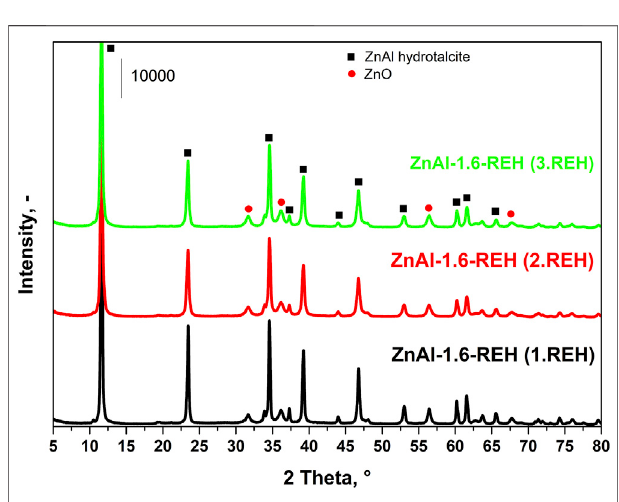
FIGURE 7 | XRD patterns of three subsequent cycles of reconstruction of ZnAl-1.6-400 mixed oxide.